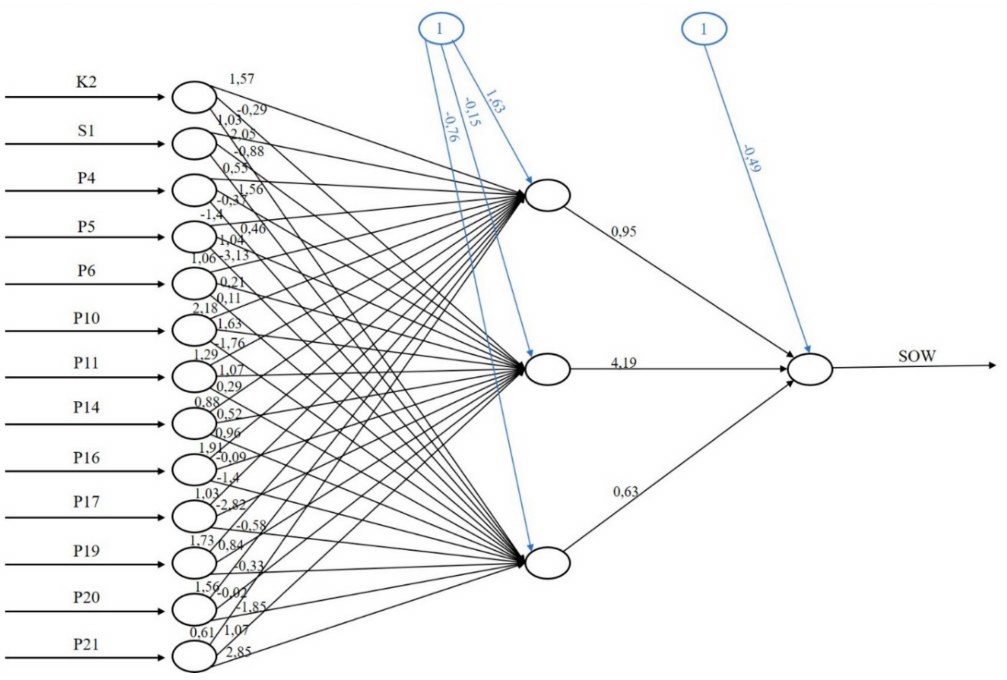
Figure 6. Neural network for the projection of the loyalty of customers by Share of Wallet (SOW) measure. Source: authors’ study.